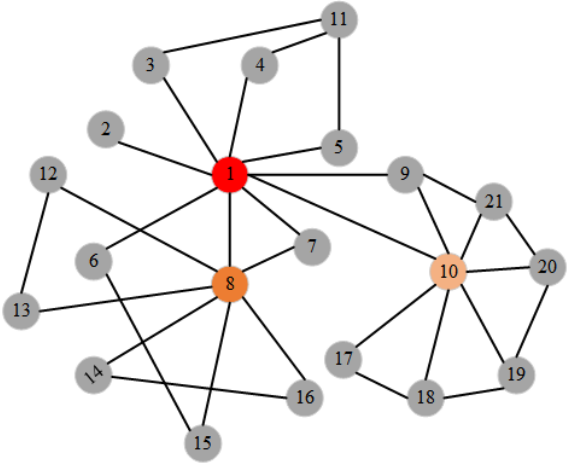
Figure 4. Original network.